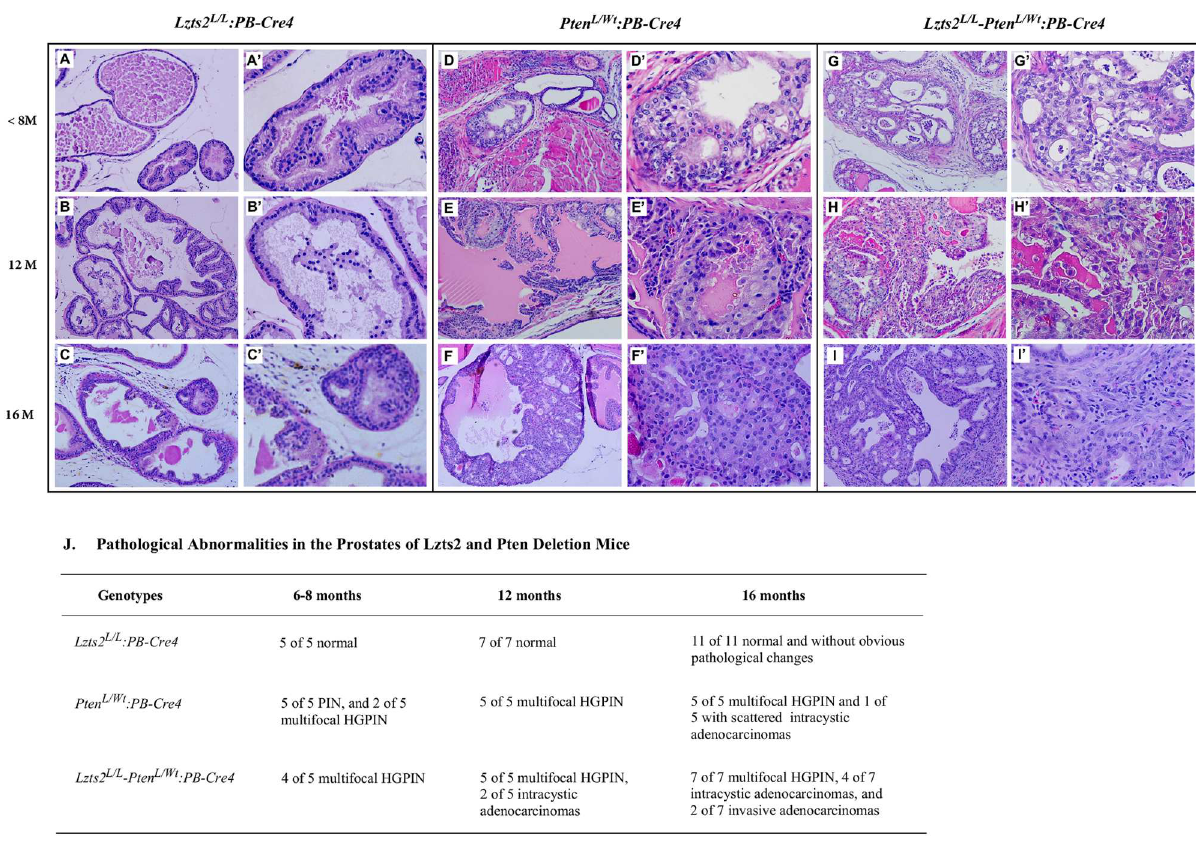
Fig 4. Prostate-specific Lzts2 deletion accelerates Pten-mediated tumorigenesis. Prostates from mice betweenthe ages of 2 to 16-monthswere analyzedfor neoplastic lesionsfollowingH&E staining as per the guidelinesfrom the Mouse Models of Human Cancers ConsortiumProstate PathologyCommittee. Panelsdepict 10x images (A-I) and 40x images (A’-I’) of Lzts2 LoxP/LoxP : PB-Cre4 (panelsA-C’), Pten loxP/Wt : PB-Cre4 (panelsD-F’), and Lzts2 LoxP/LoxP -Pten loxP/Wt : PB-Cre4 (panelsG-I’) mice. (J) Table describing pathological abnormalitiesin cohorts of aged Lzts2 LoxP/LoxP : PB-Cre4 , Pten loxP/Wt : PB-Cre4 , and Lzts2 LoxP/LoxP -Pten loxP/Wt : PB-Cre4 mice.